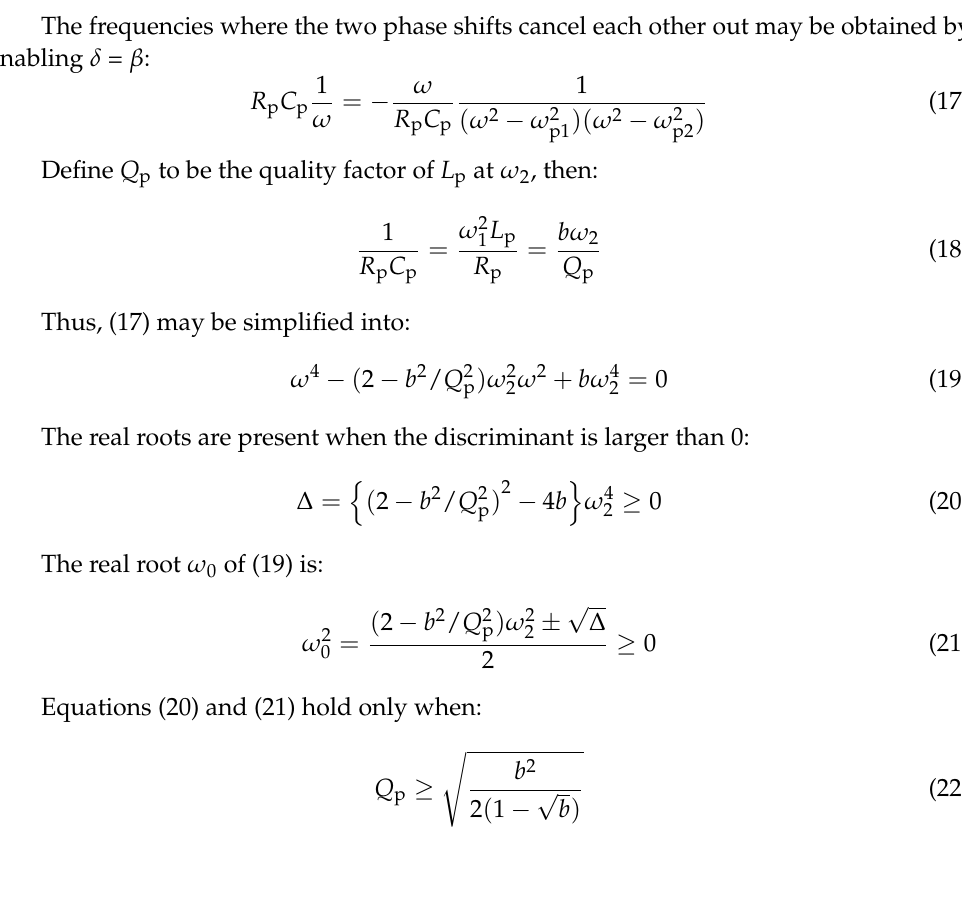
Figure 4. Calculated phase response for the tank based on Figure 3a, wherein L p and L s are both 2 nH, R p is 130 Ohms, and C p and C s are 100 fF and 50 fF,